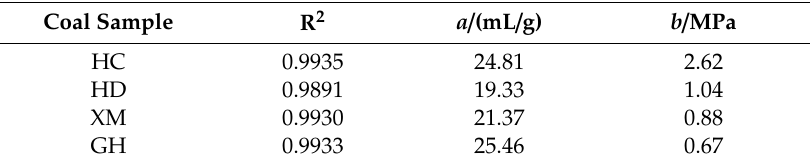
Table 3. Adsorption characteristic parameters of coal